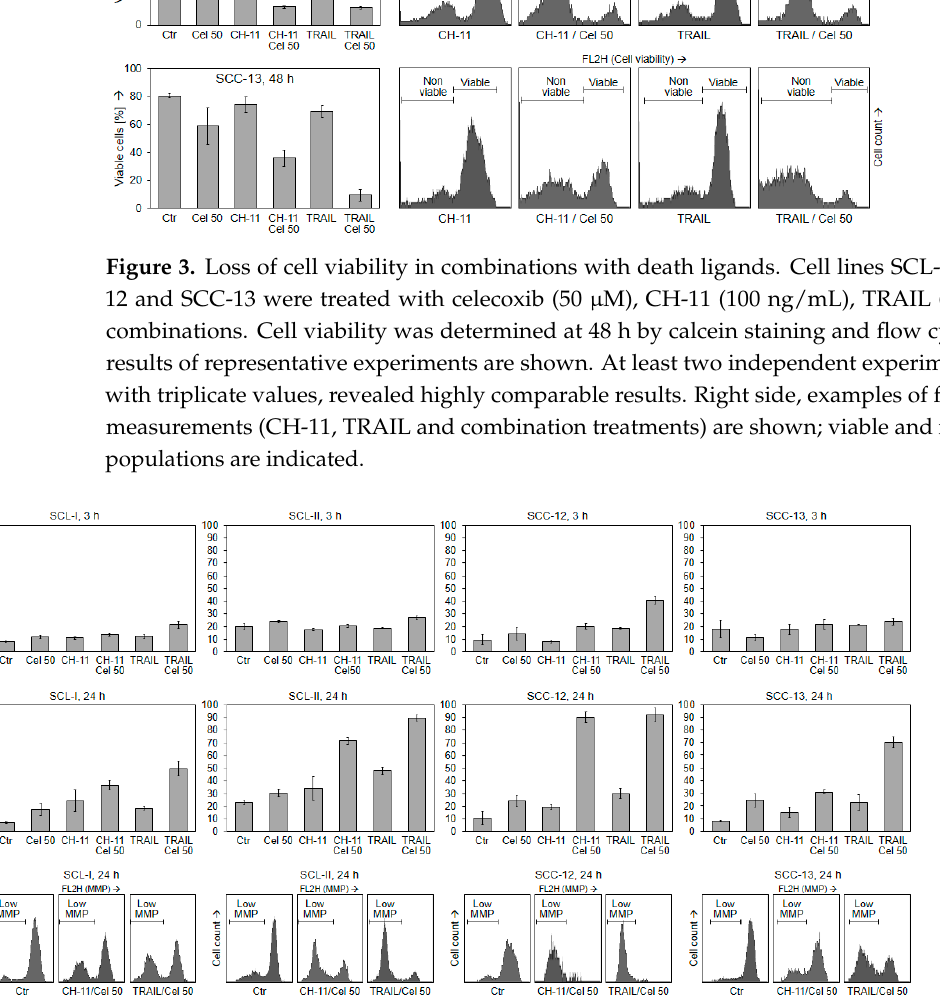
Figure 4. Changes of mitochondrial membrane potential (MMP). Four cSCC cell lines were treated with celecoxib (50 µM), CH-11 (100 ng/mL), TRAIL (50 ng/mL) or combinations for 3 h and 24 h, respectively. Percent of cells with low MMP were determined by TMRM + staining. Mean values and SDs of representative experiments are shown. At least two independent experiments, each one consisting of triplicate values, revealed highly comparable results. Example cytometry measurements of controls and combination treatments are given below; cell fractions with low MMP are indicated.